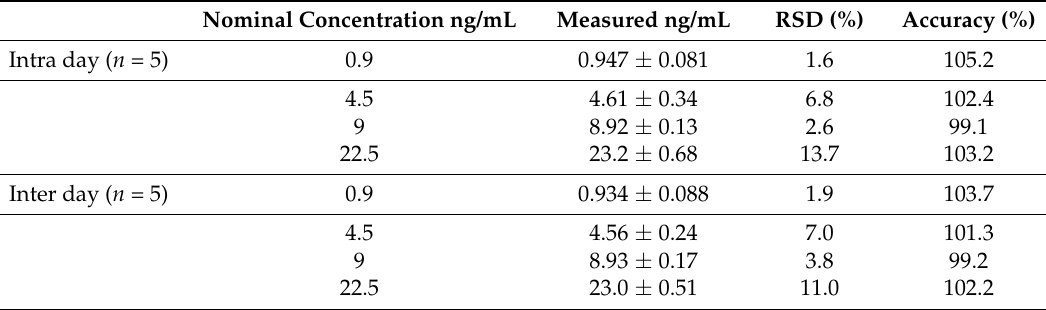
Table 2. Intra-day and inter-day precision and accuracy at different concentrations.